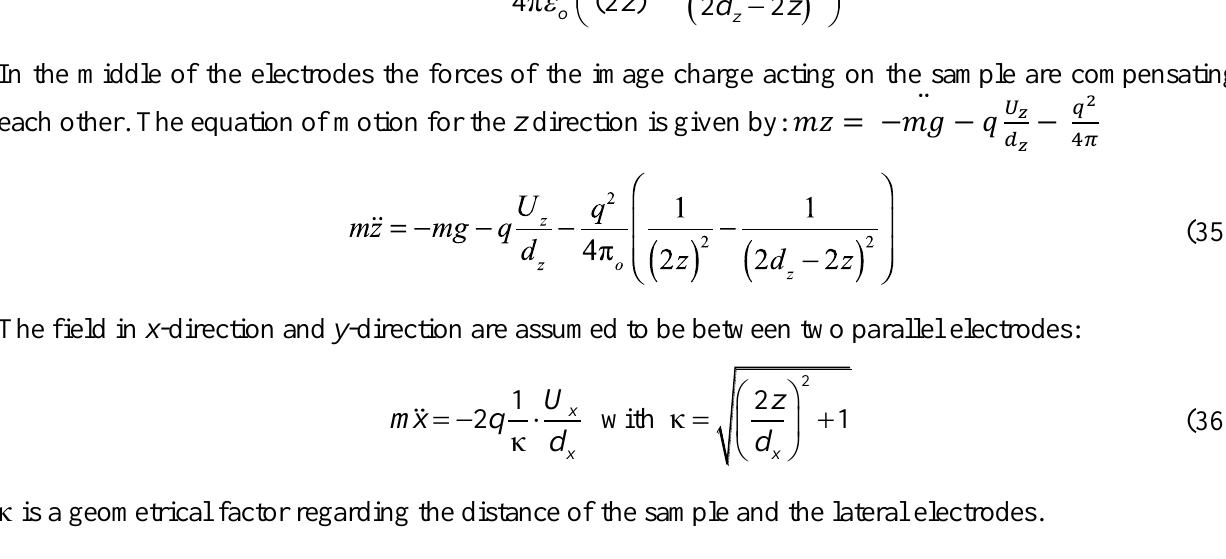
Figure 17. Sketch of the fully automated active sample positioning